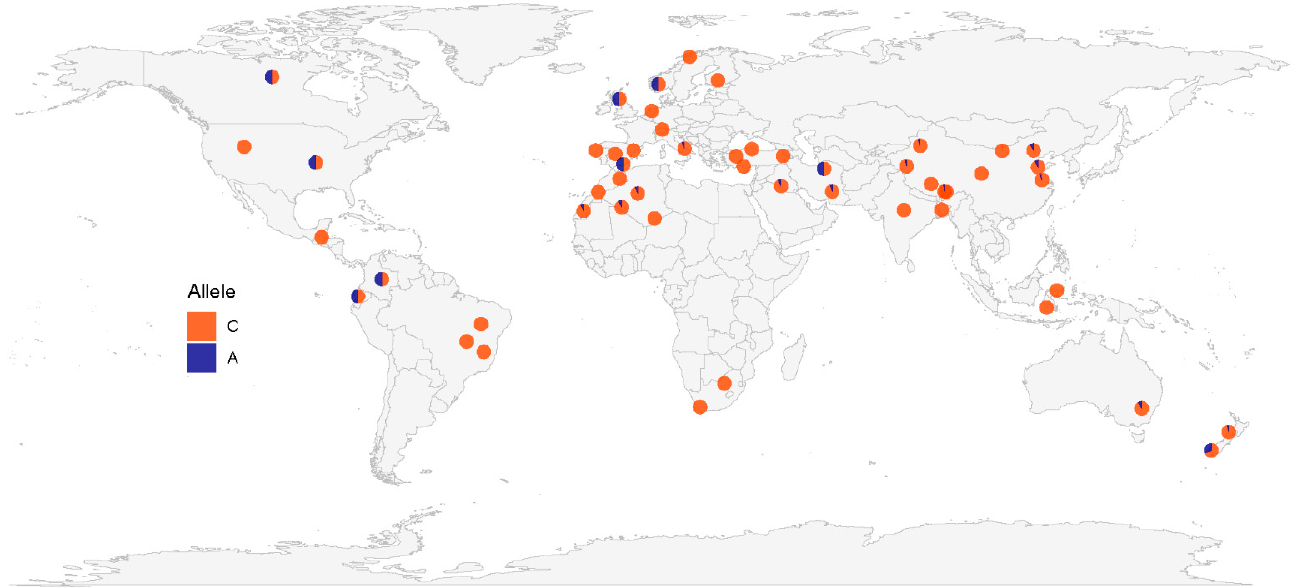
Figure 2. Allele frequency distribution of the variation c.352+342C>A in the BMP15 gene.